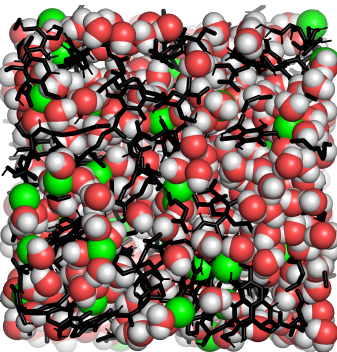
Figure A1. Exemplary representation of the molecular interactions of humic substances, calcium and water molecules. Humic substances are in black thick sticks, water molecules in space-filling representation, and calcium ions in green